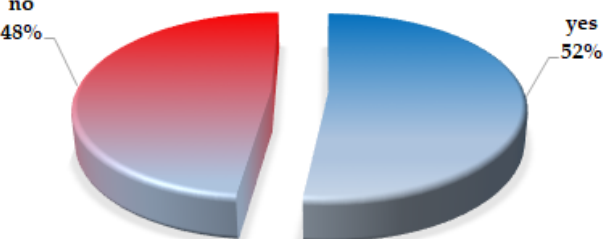
Figure 2. Declaration of respondents concerning the purchase of personalized products. Source: own study.